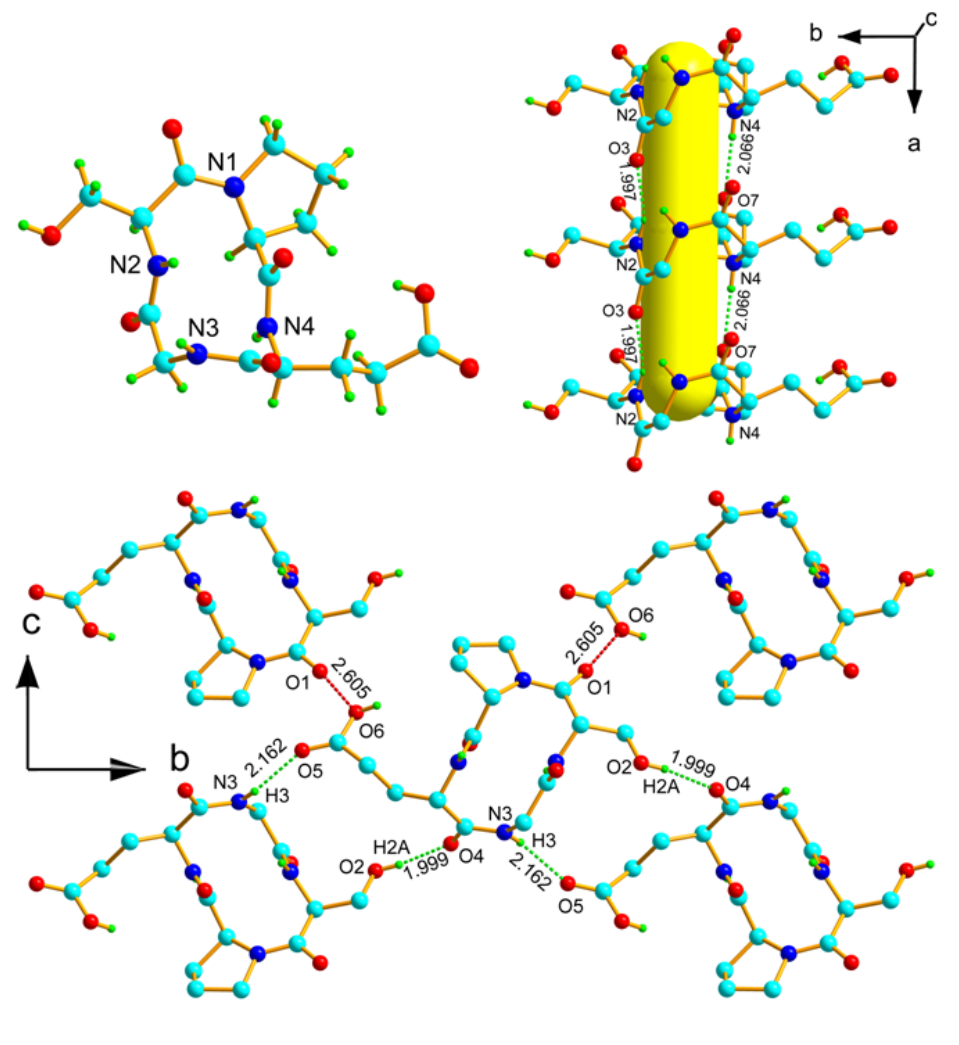
Figure 1. Thermal ellipsoid plot of cyclo (Gly- L -Ser- L -Pro- L -Glu) 1 . Color code: light gray, C; blue, N; red, O; dark gray,